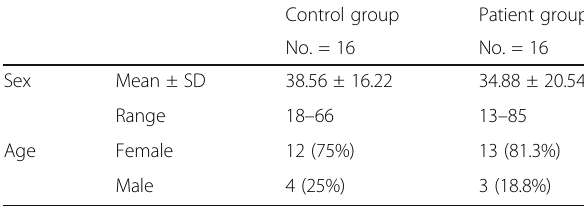
Table 1 Demographic data of the control and patient